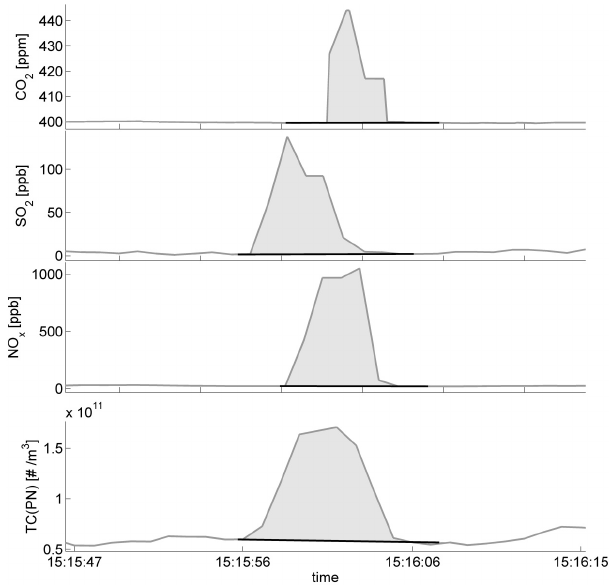
Figure 1. Example of a plume transect measurement. The volume mixing ratios of CO 2 , SO 2 and NO x are measured. The presented total concentration of particles, TC(PN), is calculated from the mea- surement of the particle number over size distribution. The volume mixing ratios and particle concentration above the respective base- lines (black line) are summed up along the transect path. The ratio of the areas (light grey) for SO 2 , NO x and TC(PN) to CO 2 is pro- portional to the respective emission factor expressed in gkg − 1 particleskg − 1 fuel